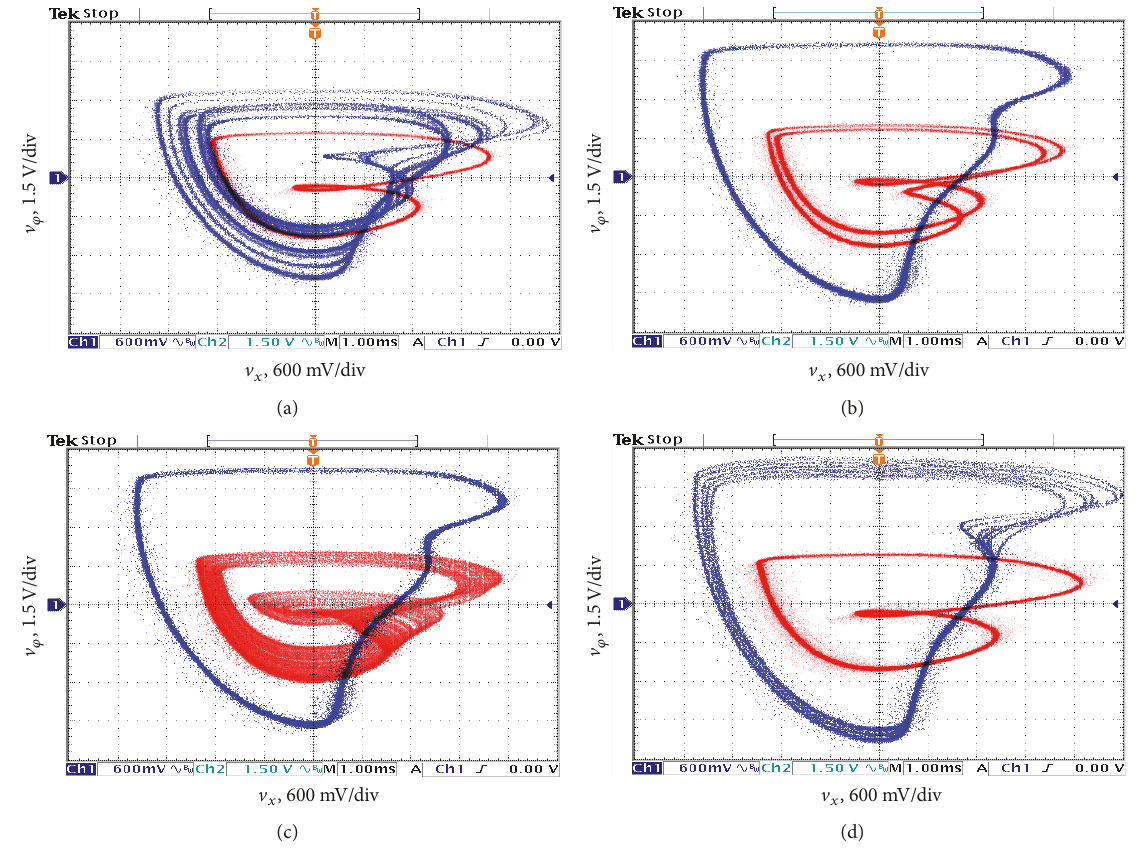
Figure 13: Experimentally measured phase portraits in the V 𝑥 - V 𝜑 plane for hidden coexisting asymmetric attractors under different circuit parameters. (a) 𝑅 1 = 10k Ω and 𝑅 𝑘 = 1.36k Ω . (b) 𝑅 1 = 10k Ω and 𝑅 𝑘 = 1.23 k Ω . (c) 𝑅 1 = 8.70 k Ω and 𝑅 𝑘 = 1.11k Ω . (d) 𝑅 1 = 6.17k Ω and 𝑅 𝑘 = 1.11k Ω